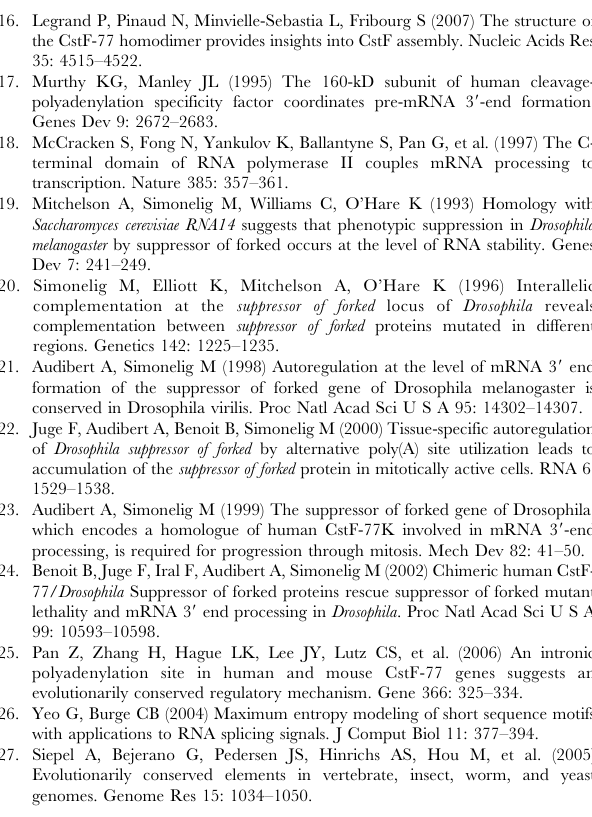
pRiG construct containing the intronic pA of CstF-77. Bottom, analysis of pA usage using pRiG. Figure S8 Introns containing pAs upregulated in C2C12 differentiation tend to have a weak 5 9 SS. Boxplot of 5 9 SS strength (MaxEnt score) for introns containing upregulated pAs (red) and other introns containing pAs (grey). Figure S9 Splicing factors are generally downregulated in C2C12 differentiation. Cumulative fraction lines for gene expression changes of splicing factor genes (172 in total) and of other genes are shown. P-value based on the Kolmogorov- Smirnov (KS) test is shown, which compares the distributions of two gene sets. The data were derived from the microarray dataset GSE11415 in the GEO database.